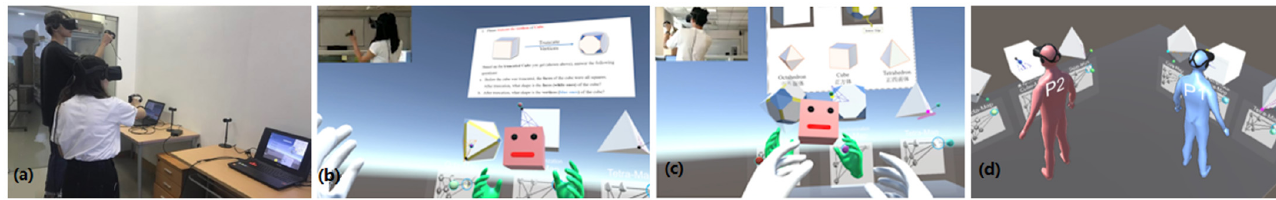
Figure 6. ( a ) Two users are interacting collaboratively with the visual objects in the virtual reality tool. ( b , c ) Each user is represented as an avatar and can see what actions the other user is doing within the virtual environment. ( d ) The corner-to-corner position of the avatars and user workspaces—this is one of the three possible position arrangements in the virtual environment.